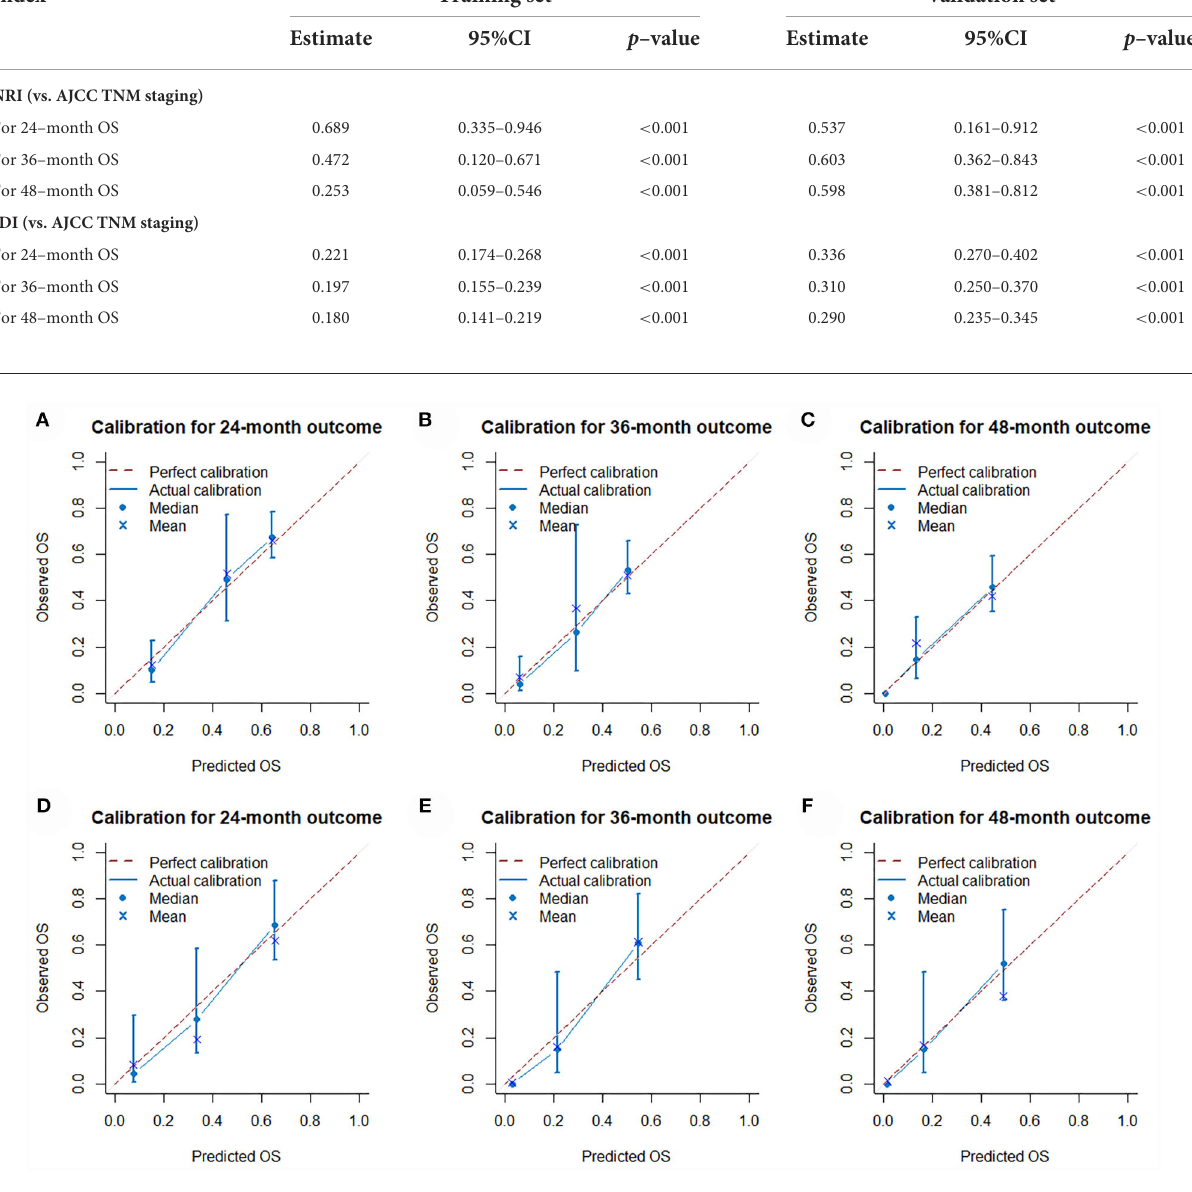
FIGURE10 Calibration curves of 24- (A) , 36- (B) , and 48-month (C) OS in the training set and 24- (D) , 36- (E) , and 48-month (F) OS in the validation